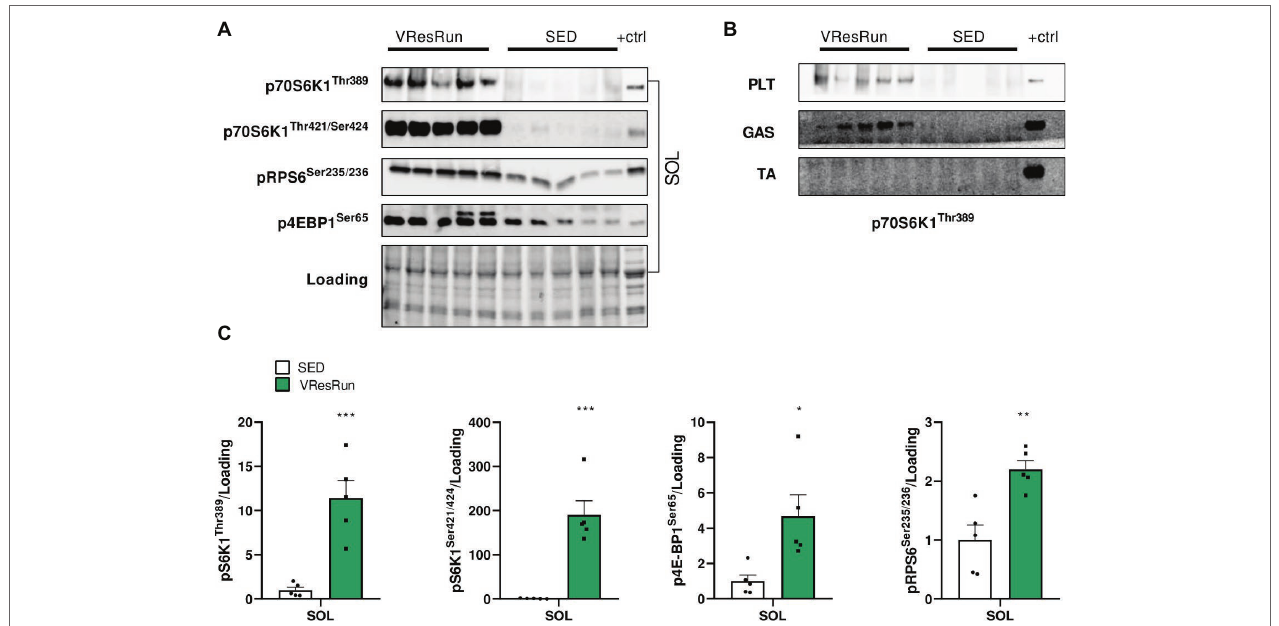
FIGURE 2 | The effect of one night of voluntary resistance running (VResRun, n = 5) on mTORC1 downstream signaling. (A) Representative blots of pS6K1 Thr389 , pS6K1 Thr421/Ser424 , pRPS6 Ser256/236 , p4EBP1 Ser65 in SOL. (B) Representative blots of pS6K1 Thr389 in PLT, GAS, and TA. (C) Quantifications. (Sed; n = 5). * p < 0.05 vs. SED, ** p < 0.01 vs. SED, *** p < 0.001 vs.